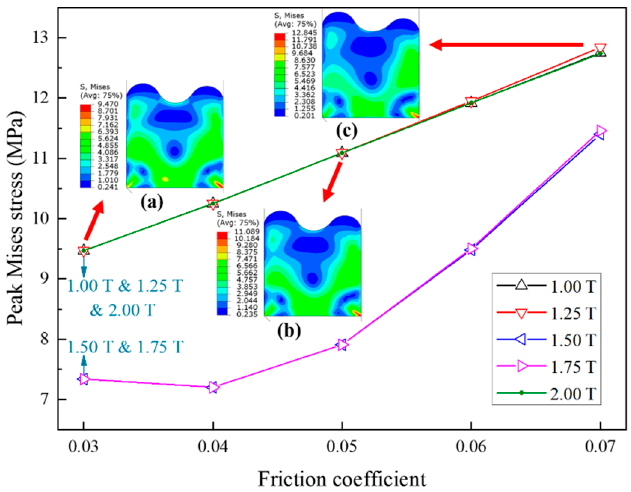
Figure 9. Relationship between peak contact pressure and C f during 1–2 T. ( a ) Schematic diagram of the forces on the X-ring during 1–1.25 T and 1.75–2 T; ( b ) Schematic diagram of the forces on the X-ring during 1.25–1.75 T.